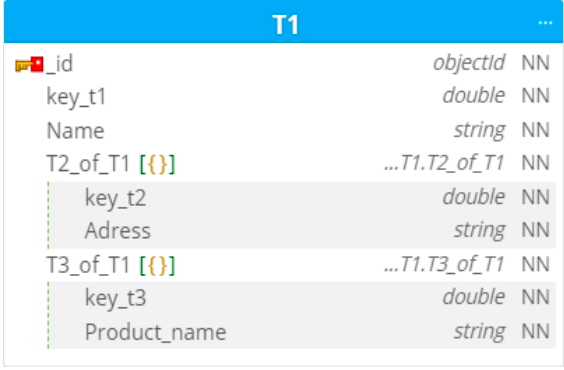
Figure 5. A single MongoDB collection without embedded documents.